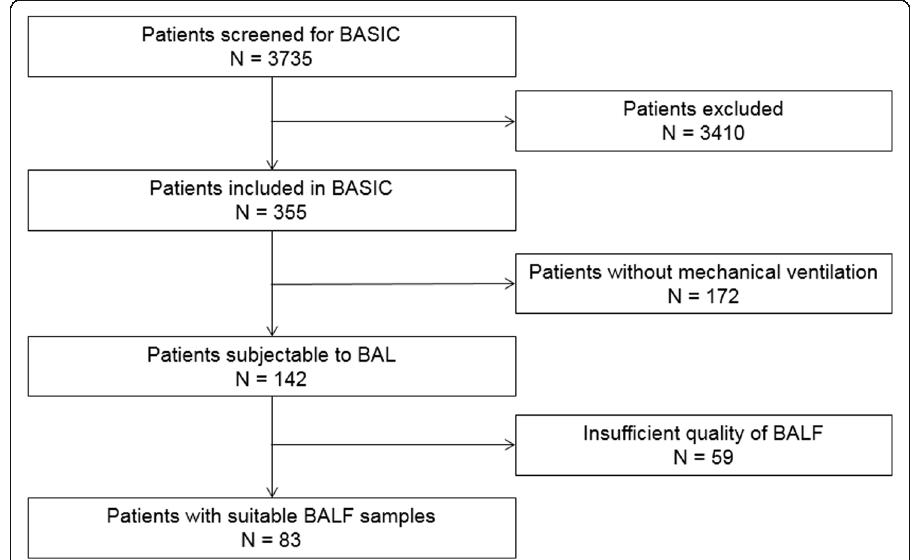
Fig. 2 CONSORT diagram of the clinical study. Abbreviations: BASIC, “ biomarker analysis in septic intensive care patients ” ; BAL, bronchoalveolar lavage; BALF, bronchoalveolar lavage